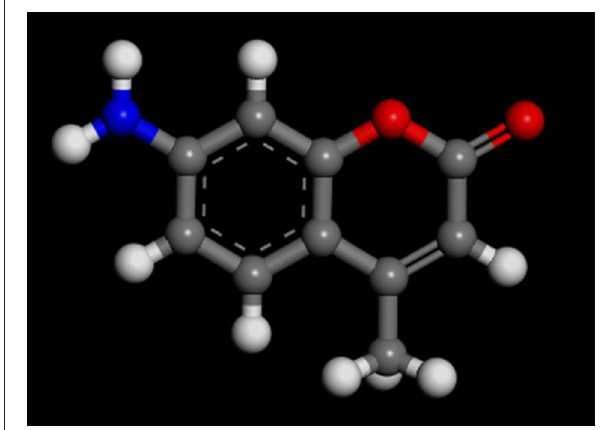
FIGURE 1 | Molecular structure of AMC studied. The all strains, C, gray; N, blue; O, red; H, white.